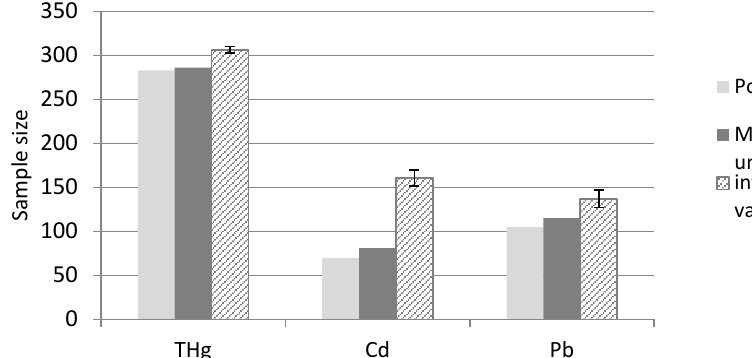
Figure 5. The sample size required to detect a 10% di ff erence in mean values between two population groups depending on the (1) population variability, (2) population variability and measurement uncertainty within one lab, and (3) variability among di ff erent laboratories (inter-laboratory variability). Bars represent variation due to the use of di ff erent ILC samples. ILC, inter-laboratory